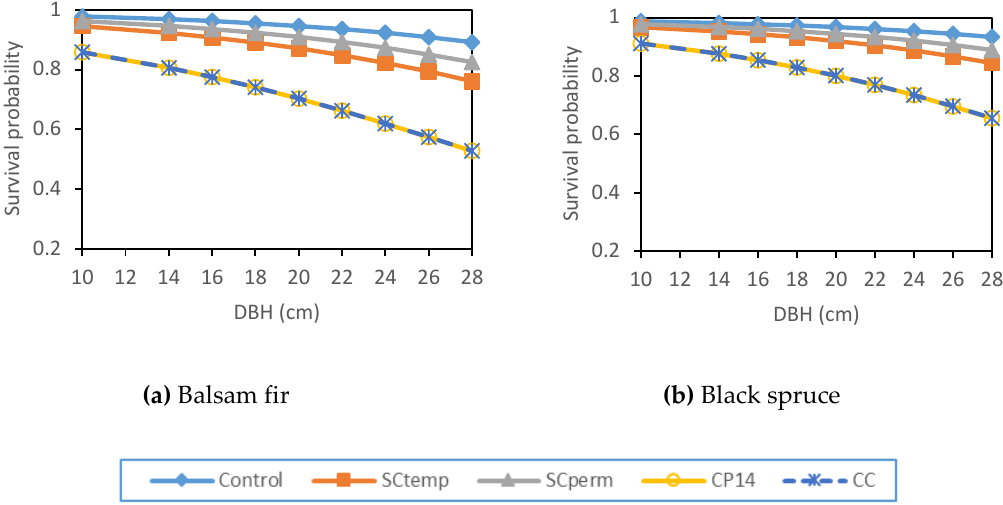
Figure 4. Probability of survival for ( a ) balsam fir and ( b ) black spruce trees according to treatment, when treatments are applied in uncut landscapes [36].